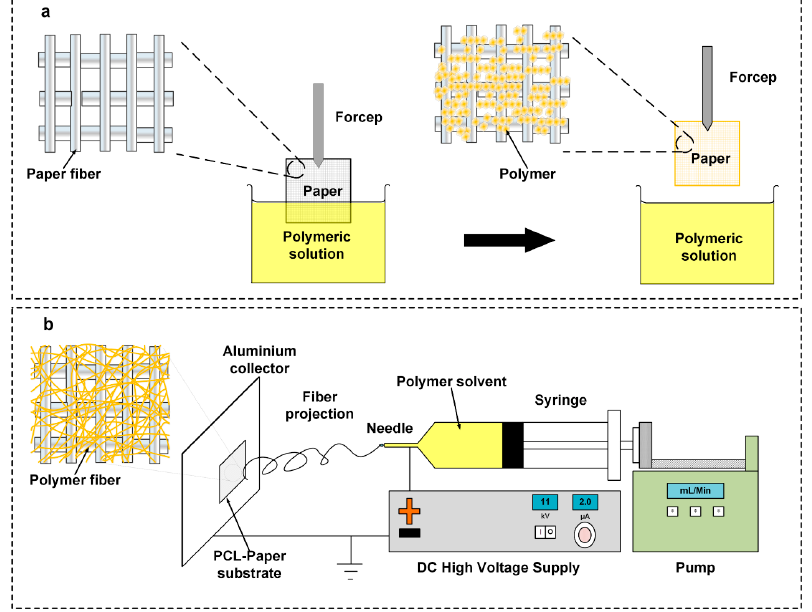
Figure 1. Schematics of filter paper modification. ( a ) Dip-coating of filter paper with polycaprolactone (PCL) solution (DFP), ( b ) Electrospinning of PCL on Filter paper (ES-PCL/FP).